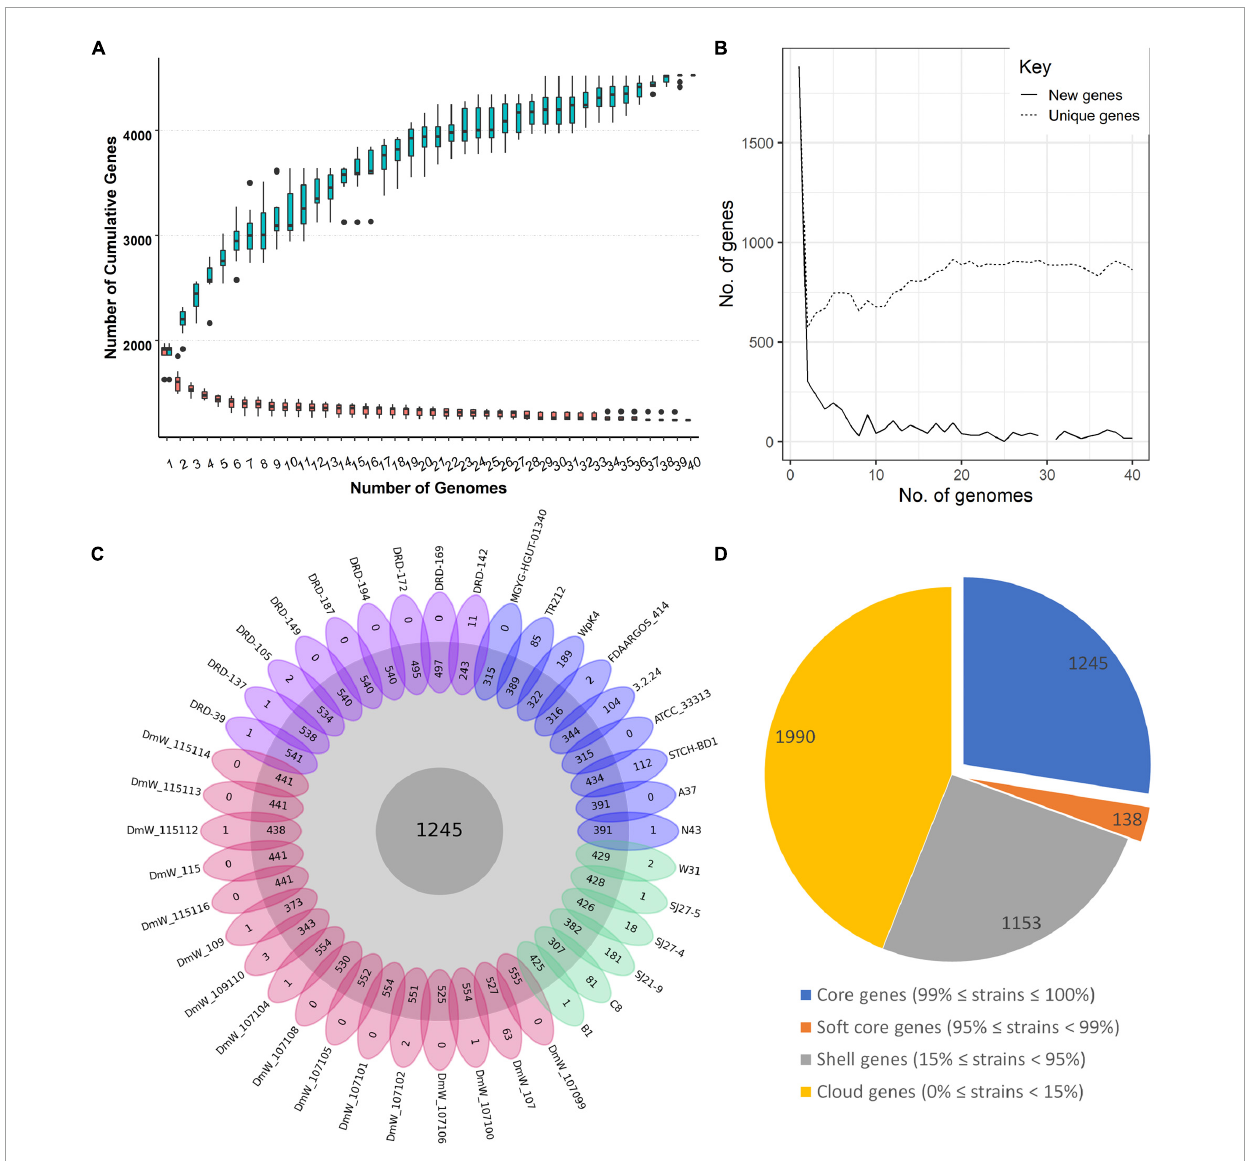
FIGURE1 Core genome and pan genome of the 40 Weissella paramesenteroides strains. (A) The Pan-genome development of W. paramesenteroides by including the genomes one-by-one. (B) The number of unique and new genes in the pangenome. (C) A flower plot indicating the core genes in the center, the number of accessory genes for each strain in the outer circle, and unique genes for each strain in the petals, DRD strains in purple, DmW strains in red, our strains in green, individual strains in blue. (D) The summary of CDS distribution among the strains presented in a pie chart, core genes- present in all of the strains, soft core genes- present in more than 38 of the strains, shell genes- present in 6–37 of the strains, cloud genes- present in one or two strains only.